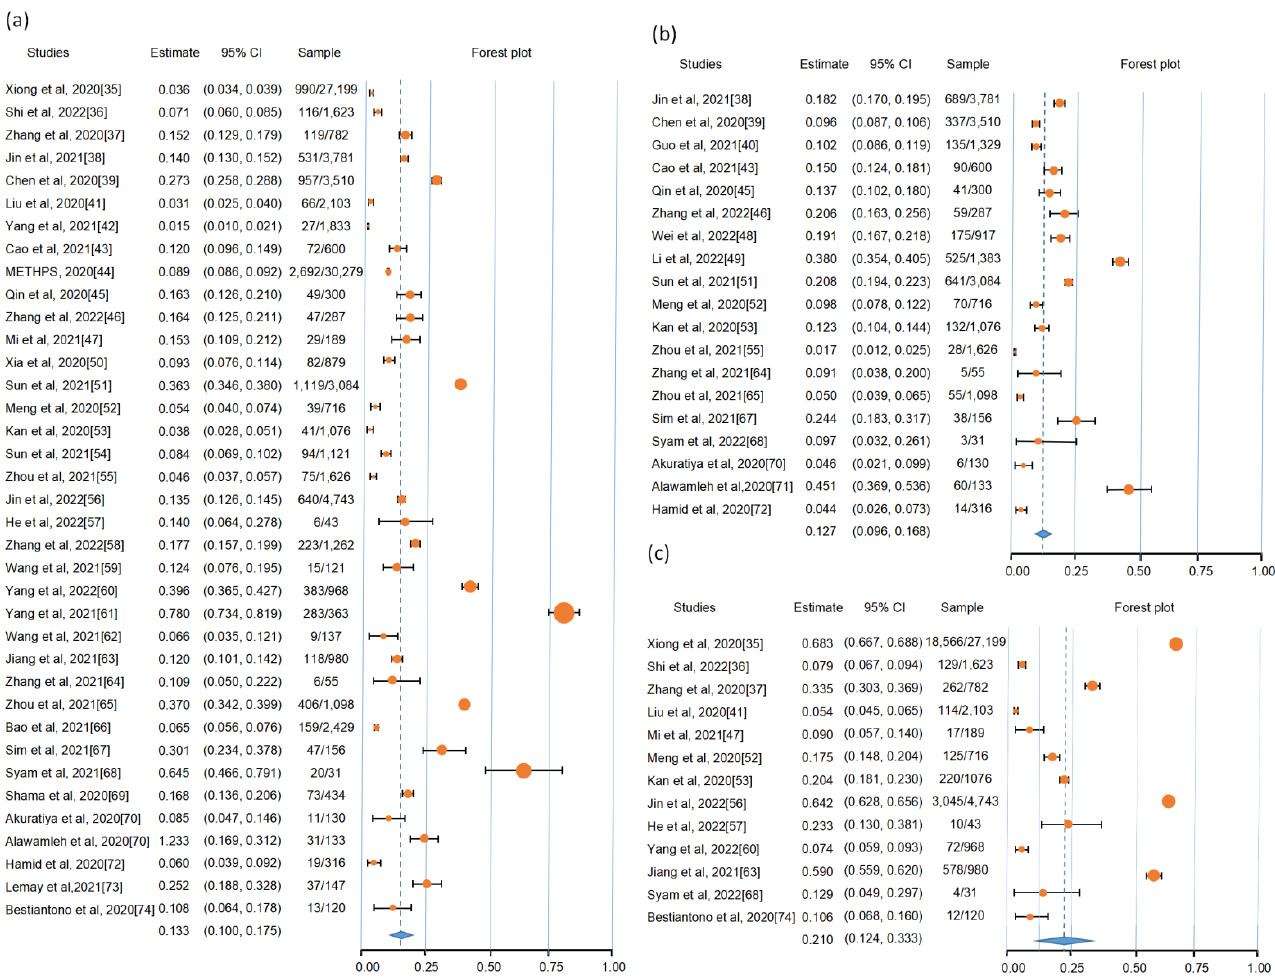
Figure 2. Forest plot for meta-analytic results. ( a ) The negative attitude for online learning during